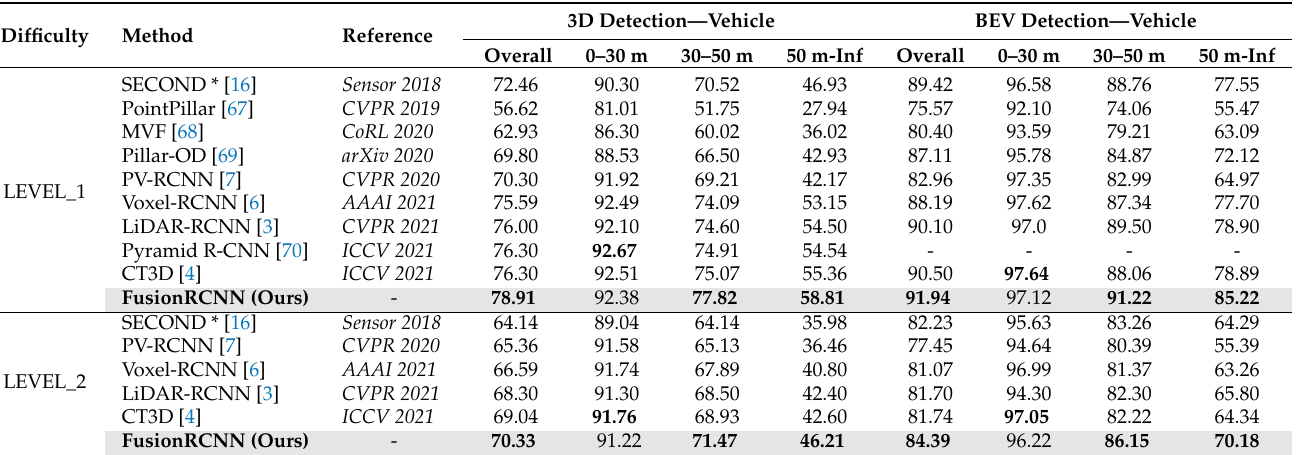
Table 1. Performance comparisons with state-of-the-art methods of vehicle detection on the Waymo dataset with 202 validation sequences ( ∼ 40 k samples).*: re-implemented by ourselves on OpenPCDet. The top results are bolded in the table.